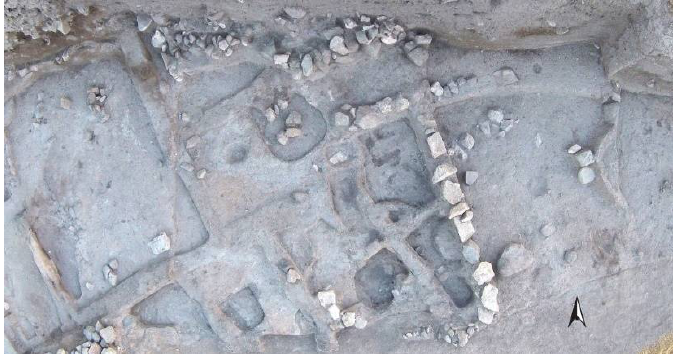
Figure 10. Aerial photo of Lower Town showing major stone foundations of Non-Domestic Building.